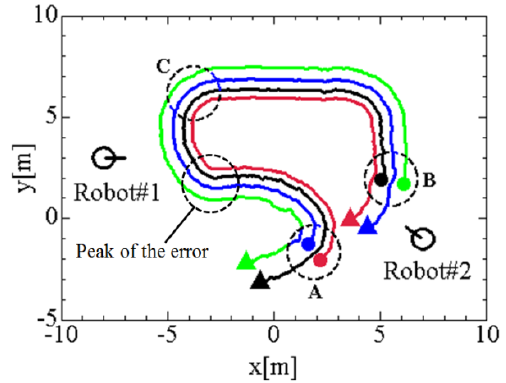
Figure 7. Simulation condition. Red, blue, green and black lines indicate moving path of pedestrians #1, #2, #3 and #4,